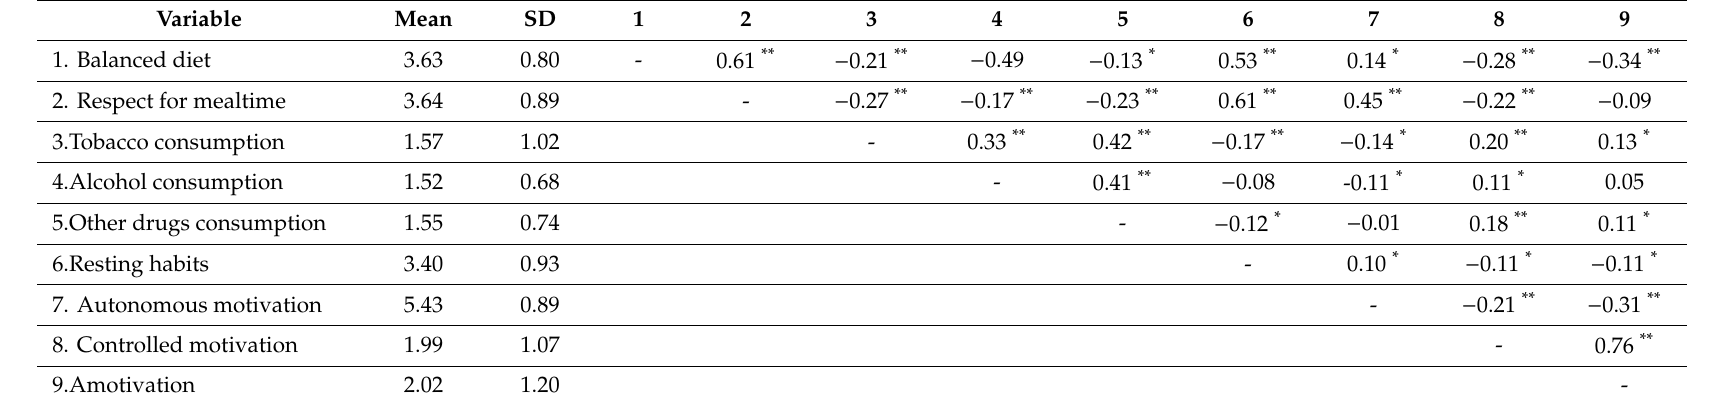
Table 2. Descriptive statistics and concurrent validity between the variables of EVS II and